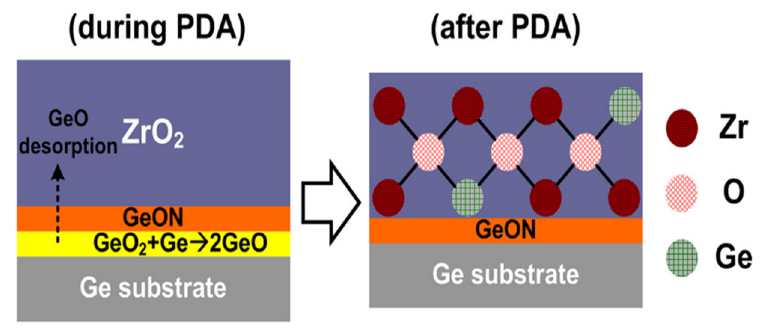
Figure 8. Nitriding treatment and GeO 2 thermal decomposition into the ZrO 2 layer to form a stable crystal state [78]. Reprinted from [78]; 2013 AIP Publishing.